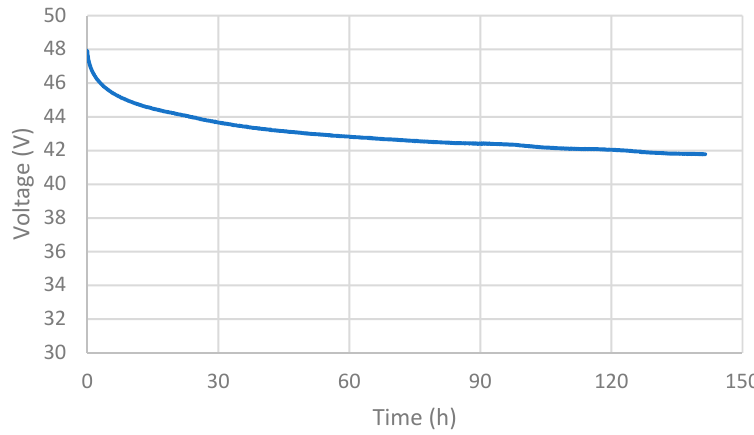
Figure 1. Self-discharge of the supercapacitor (SC) module over a period of 140 hours.